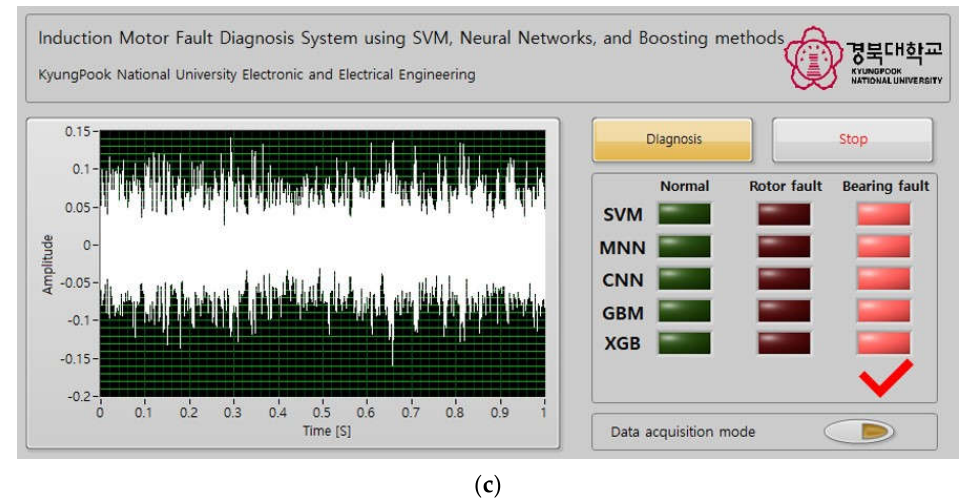
Figure 13. Fault diagnosis and results of induction motor using graphical user interface. ( a ) Results of normal state induction motor fault diagnosis using graphical user inter-face. ( b ) Results of rotor fault state induction motor fault diagnosis using graphical user interface. ( c ) Results of bearing fault state induction motor fault diagnosis using graphical user